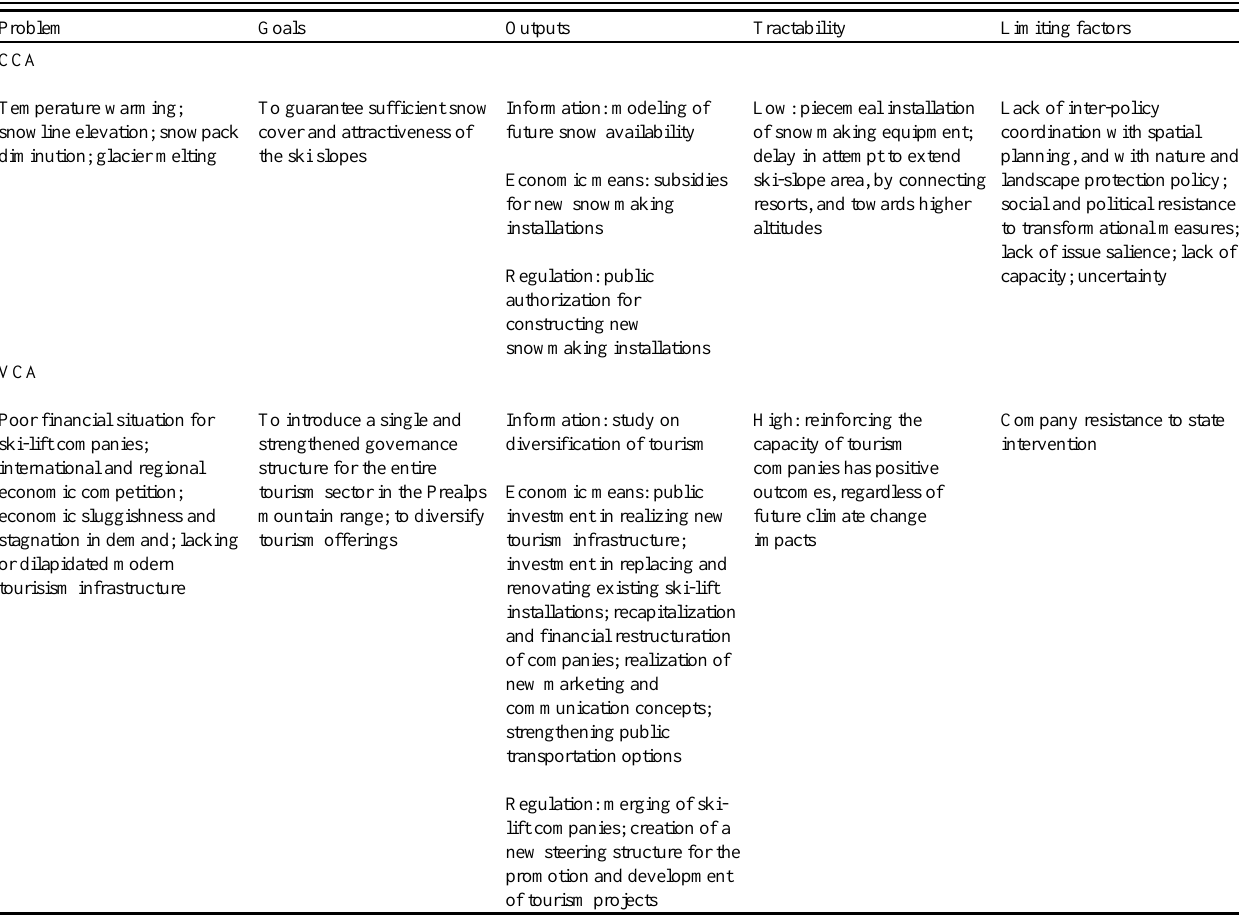
Table 5. Summary of the Alpes Vaudoises rural development policy and analysis of